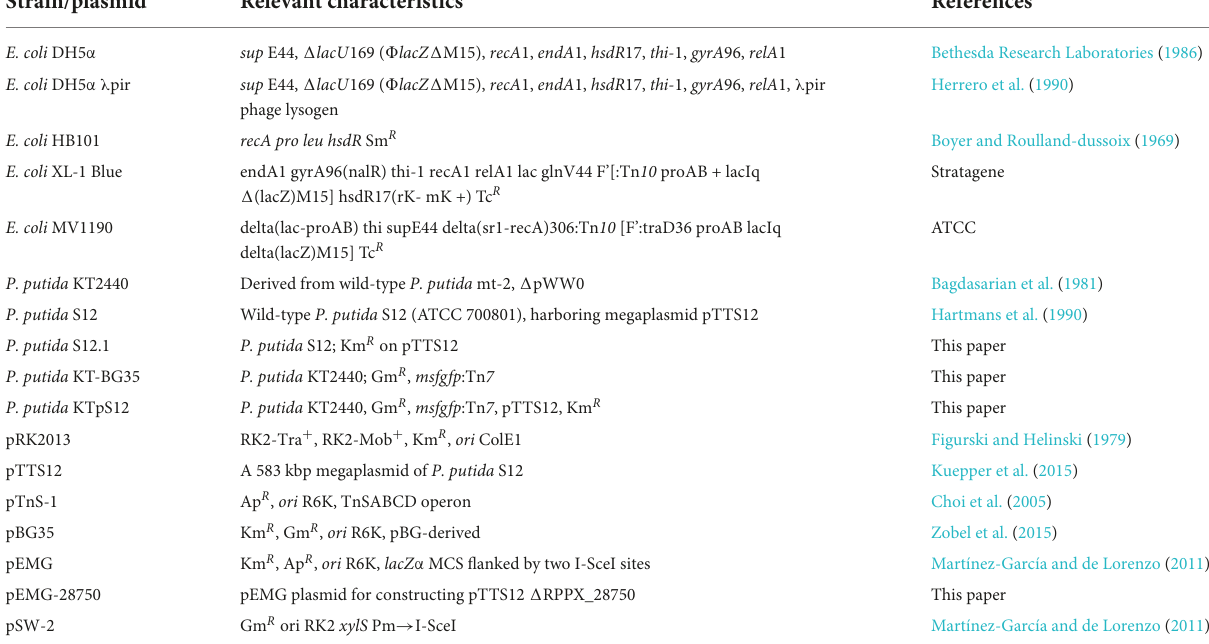
TABLE 1 Bacterial strains and plasmids used in this